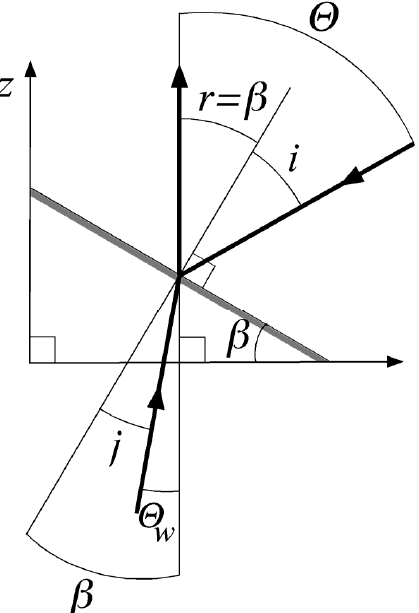
Fig. 2. Vertical section in the steepest direction of the sloping surface, indicated by the grey line. A ray from the zenith angle θ in the sky has an angle of incidence i and is reflected towards zenith in an angle of reflection r equal to i and slope angle β . A ray from the nadir angle θ w in the sea has an angle of incidence j and is refracted through the surface at an angle of refraction r with a direction towards zenith.